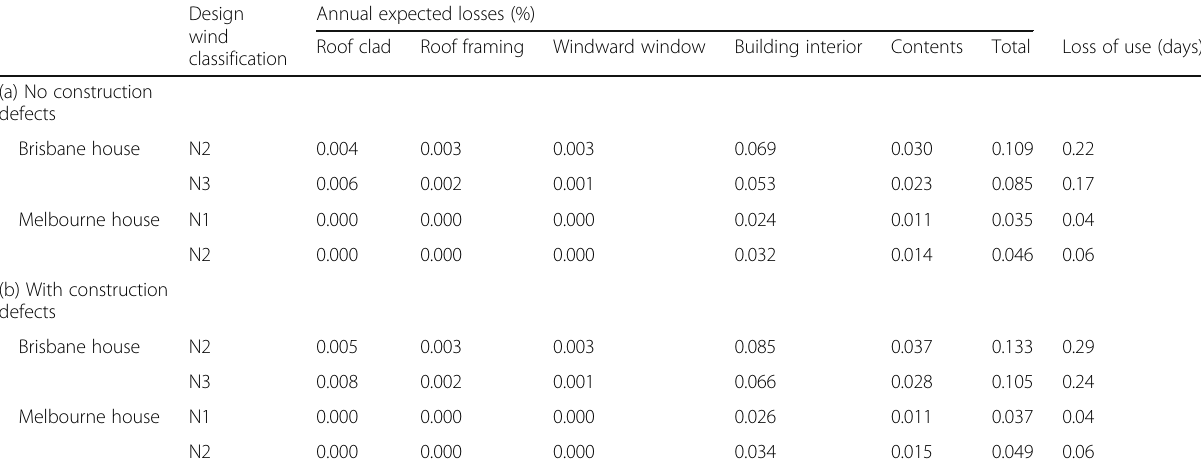
batten (CTB) connections (RF), (ii) protection of windows by shutters (WS), (iii) improvement of window resistances (WR), and (iv) use of water-resistant materials for ceiling and internal wall finishes (IW). The fragility analysis re- veals that the damage proportions of BTR and RTW con- nections are considerably less than the failures of CTB connections [28], and hence RF is to strengthen CTB con- nections by (i) increasing the base metal thickness (BMT) of metal roof cladding from 0.42 mm to 0.48 mm, and (ii) upgrading the screw fastener for CTB connections from M6 – 11 (diameter of 6.0 mm and 11 threads per inch) to 14 – 12 (diameter of 6.3 mm and 12 threads per inch). This improves the mean pull-over and pull-out capacities of CTB connections by 25% and 7%, respectively. In WS, cyclone-rated steel roller shutters tested for wind pressure up to 2500 Pa are used. The shutter strength against wind Table 5 Annual risk for the representative contemporary house Design